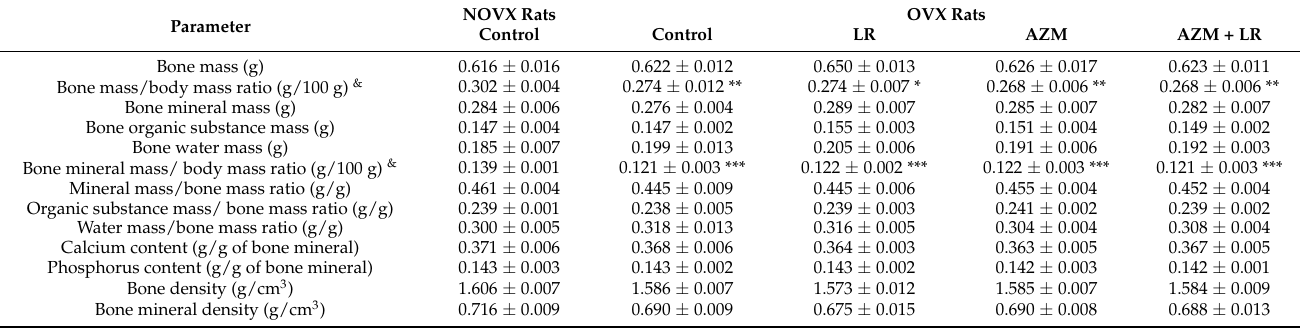
Table 2. Effect of azithromycin (AZM) and/or Lactobacillus rhamnosus (LR) on the mass, composition, mineralization, and density of the femur in ovariectomized